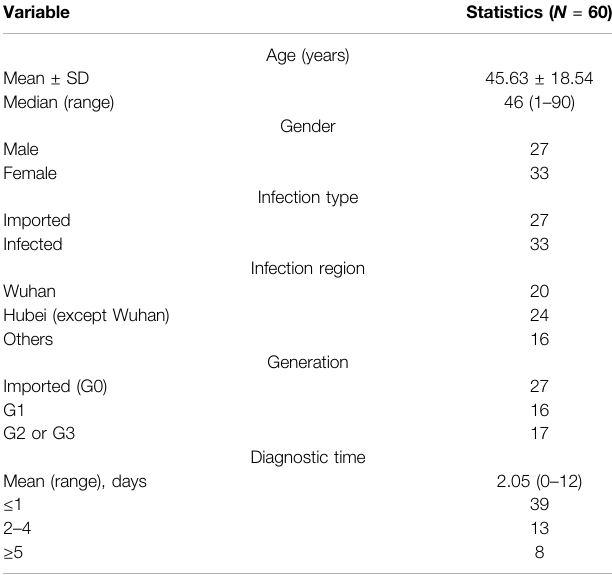
TABLE 1 | Characteristics of COVID-19 patients in Qingdao ( N (cid:1) 60).